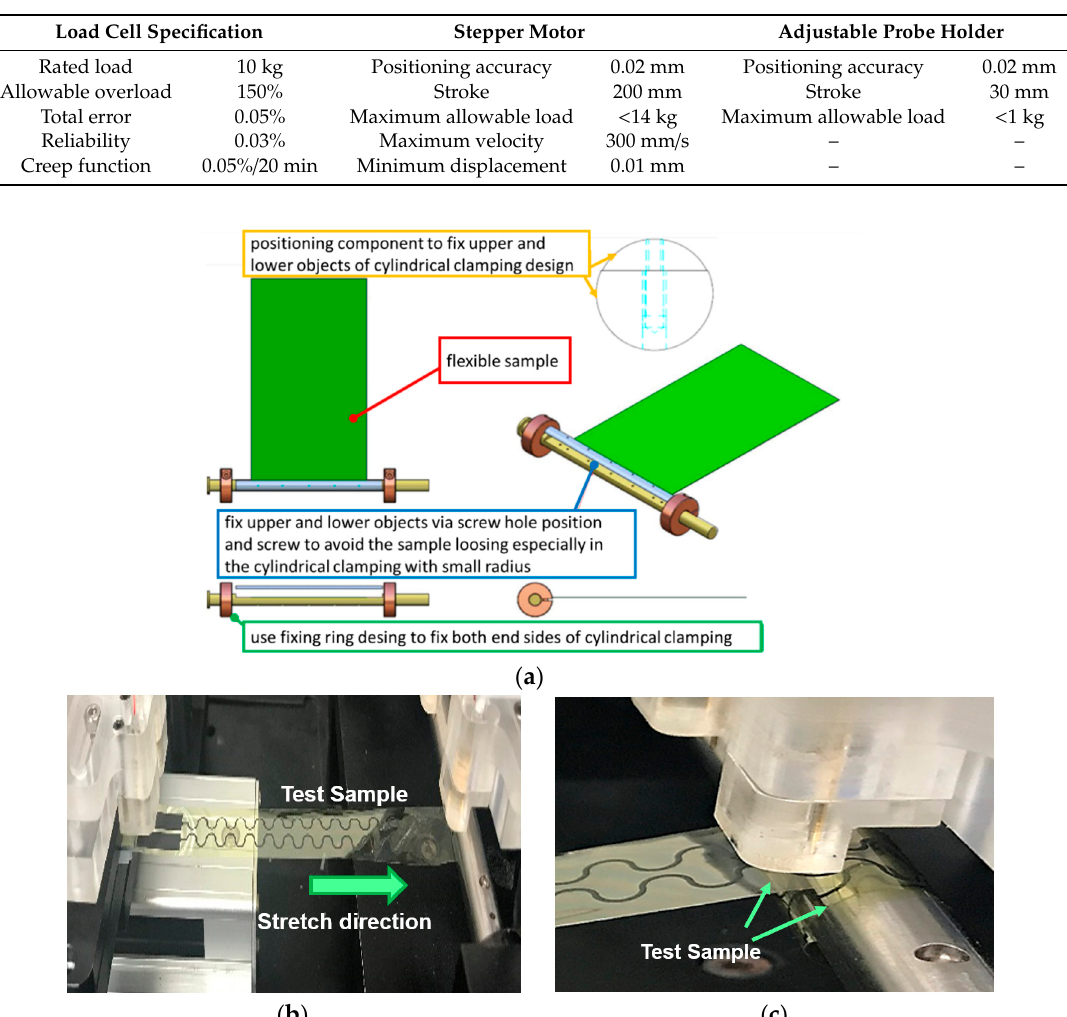
Figure 3. Adjustable cylindrical clamped design: ( a ) schematic of the clamped mechanism used in flexible specimen; ( b ) stretch mode; ( c ) rolling mode.